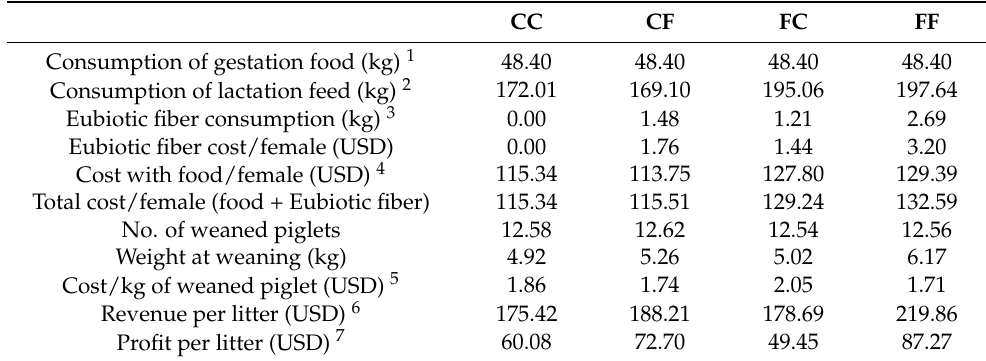
Table 11. Cost–benefit analysis of using dietary fiber (Eubiotic fiber) with sows in gestation and/or